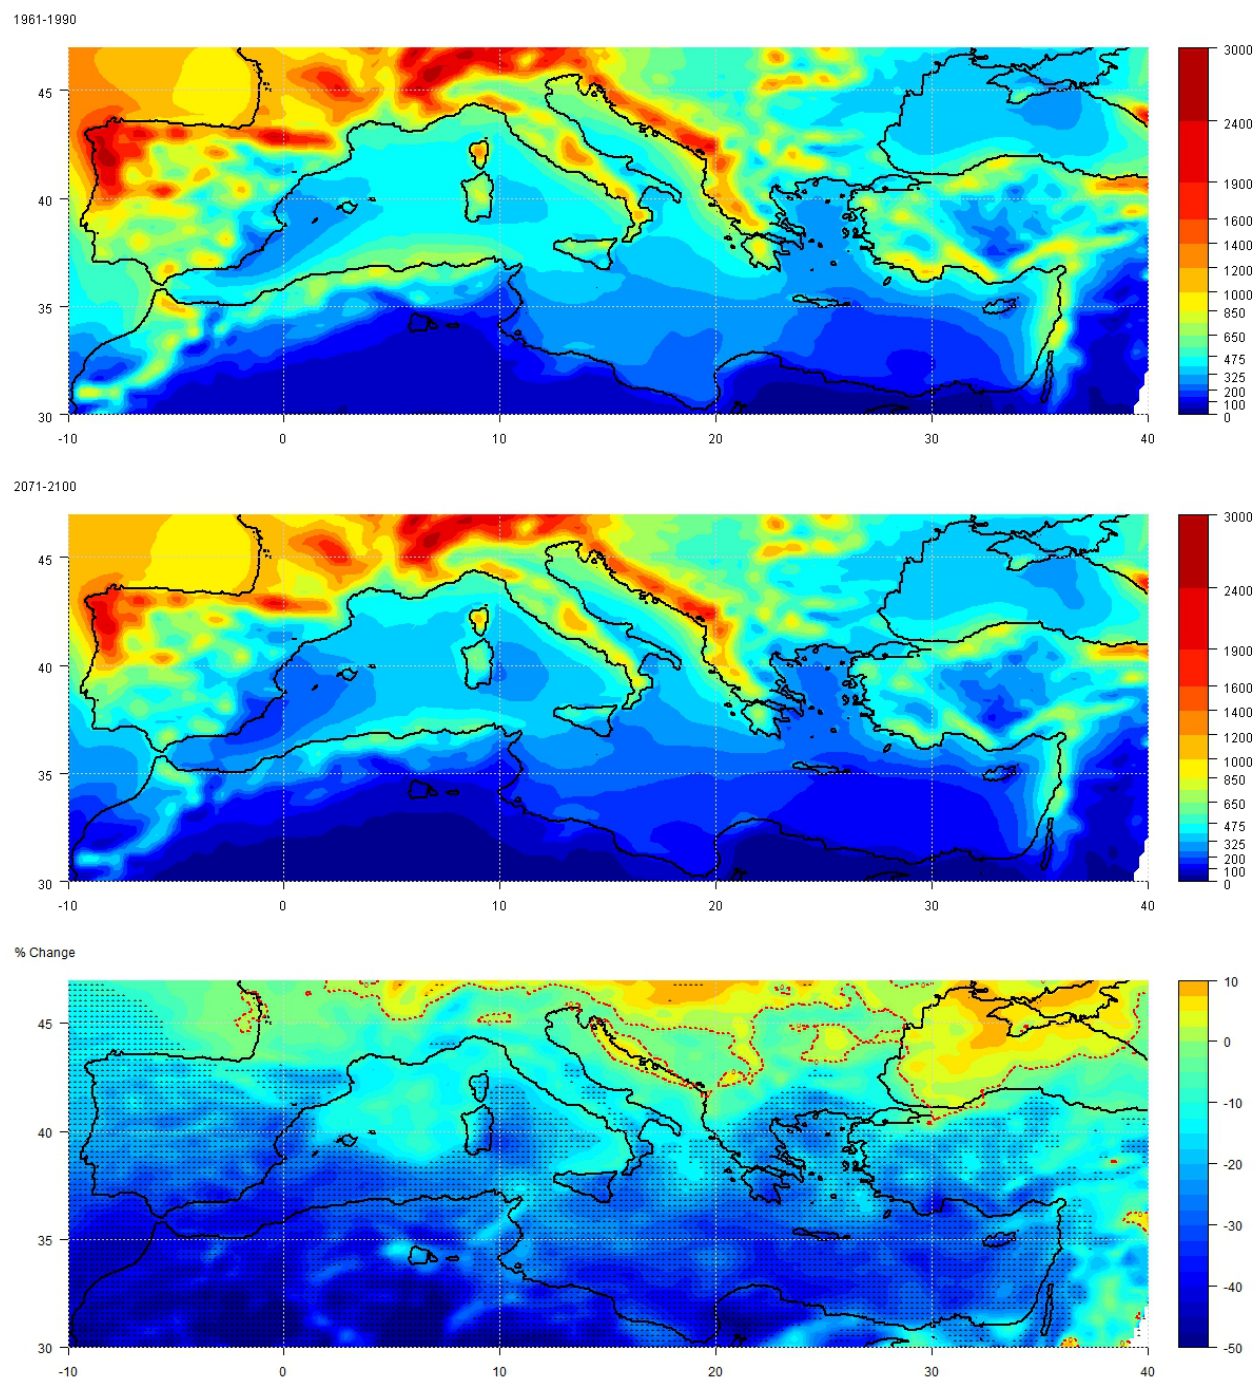
Fig. 8. Spatial distribution of mean annual precipitation totals (mm) for the reference period 1961–1990 (upper graph), the future period 2071–2100 (middle graph) and the differences of mean annual precipitation between the two periods (lower graph). Shaded areas concern statistically significant differences (95% CL).